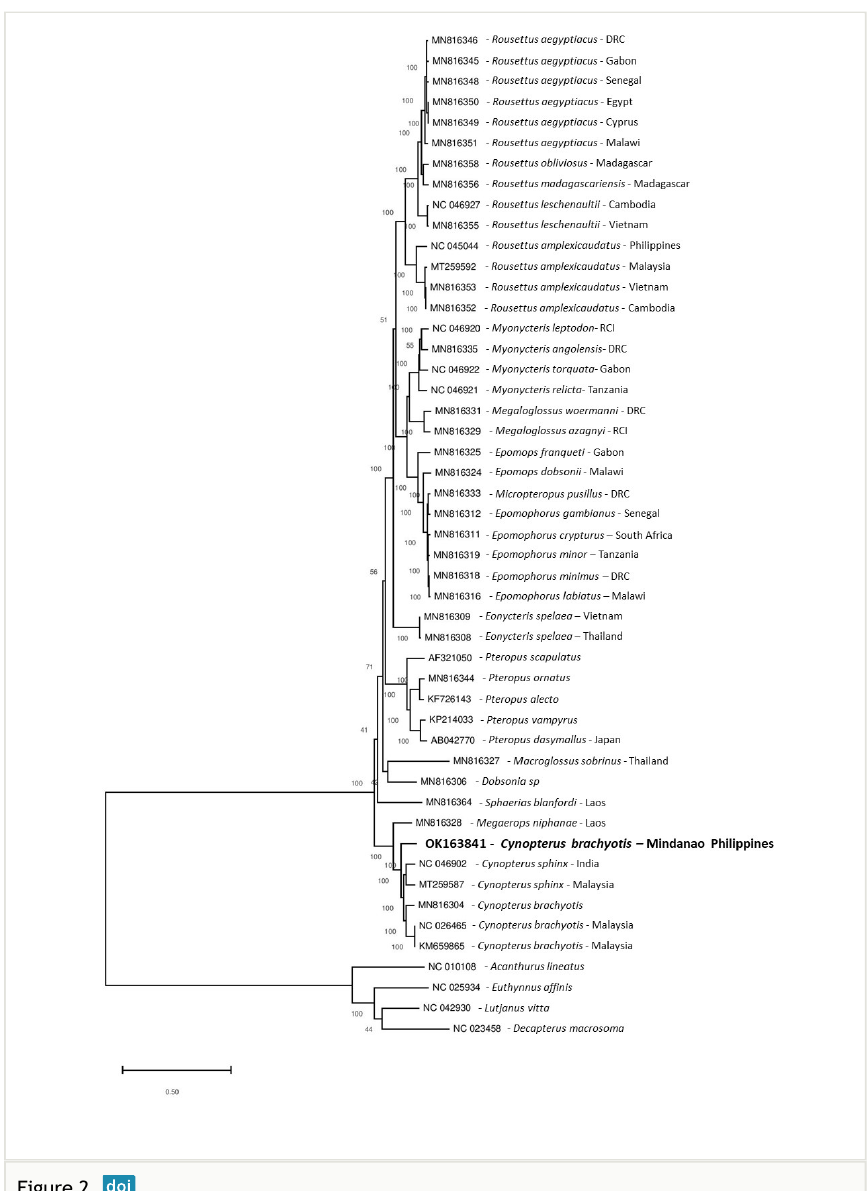
Figure 2. Maximum Likelihood phylogeny of selected fruit bat mitogenomes obtained from GenBank. The tree was generated using MEGA 7 with 1000 bootstrap replicates. The DNA substitution model used was GTR+G+I. The scale bar denotes the number of substitutions per site which is reflected in the branch lengths (i.e. 0.5 value means 5 nucleotide changes for every 10 nucleotides). Bootstrap values for clade support are written on the nodes of the branches. An outgroup consisting of fish mitogenomes was included in the phylogenetic tree